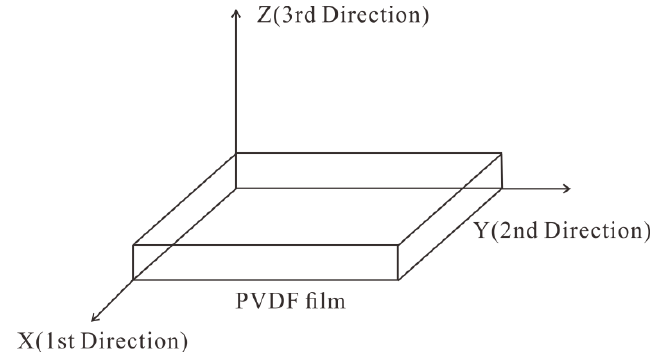
Figure 1. Directions relative to polyvinylidene fluoride (PVDF) film.